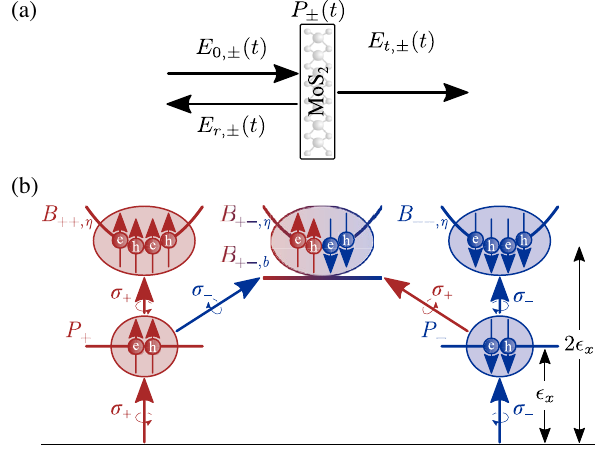
t Þ FIG. 1. (a) Illustration of the incoming light field E 0 ; (cid:3) ð driving the exciton transitions P ð t Þ . E 0 ; ð t Þ and P ð t Þ deter- (cid:3) (cid:3) (cid:3) t Þ and reflected E t Þ light fields. mine the transmitted E t; (cid:3) ð r; (cid:3) ð (bound electron-hole pairs with (b) Illustrated are excitons P (cid:3) energy ϵ ), biexcitons B (two-electron and two-hole corre- x þ − ;b lations with energy < 2 ϵ ), and two-exciton scattering continua x B and B (two-electron and two-hole correlations with þ − ; η (cid:3)(cid:3) ; η energy ≥ 2 ϵ ). The optical selection rules for σ and σ − circularly x þ polarized light are n , and the laser frequency ω . The transmitted light E ð t Þ r p t; (cid:3) given in Eq. (2) couples to the polarization density d (cid:4) P ð t Þ (cid:3) of the exciton gas and constitutes the light field at the d= ð 2 ε 0 c 0 n position of the sample. The coefficient α ¼ ω Þ p r